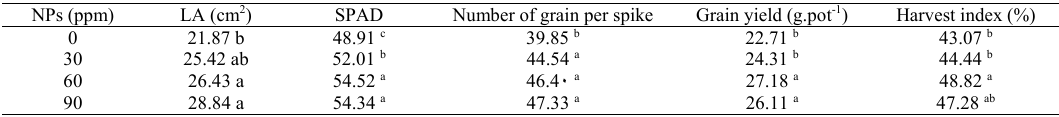
Table 3: Means comparison the effects of NPs concentration on some measured traits at barley